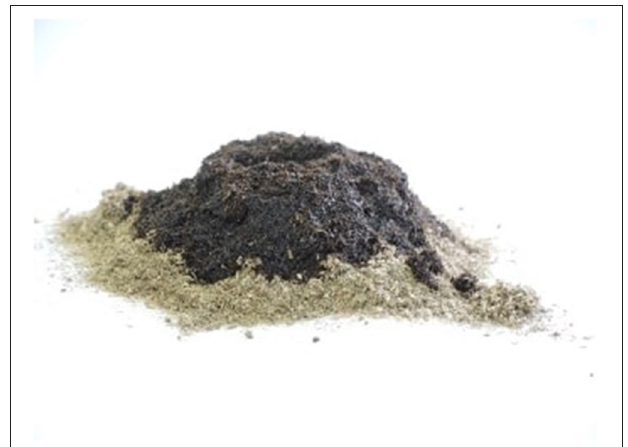
FIGURE 5 | Green Keeper Africa product derived from the water hyacinth fiber. The fiber absorbs oil-based industrial waste. Credit: Green Keeper Africa.